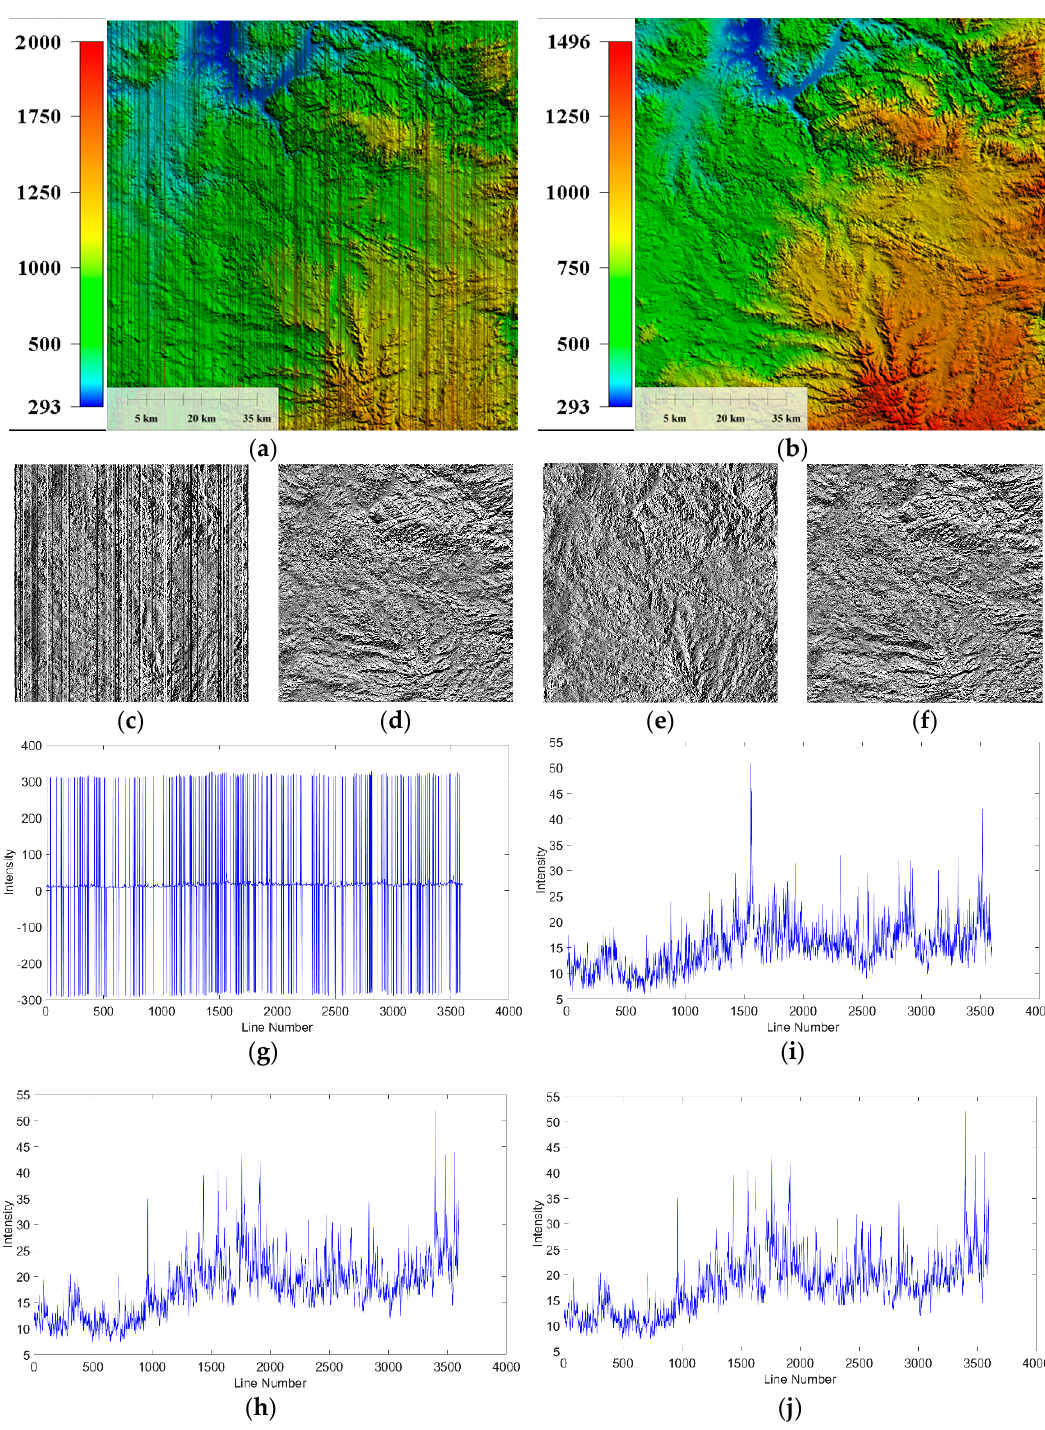
Figure 3. The interference of stripe errors on different gradient directions. The minimum elevation in this area is 293 m, the maximum elevation is 2000 m, and the maximum elevation difference is 1700 m. Analyzing the gradient decomposition in this rugged landscape, stripes of the regular distribution mainly affected the data for an elevational gradient in the direction orthogonal to it. In this experiment, stripe errors severely interfere with the horizontal gradient of the data. ( a ) Data with stripe errors, ( b ) clean data, ( c ) horizontal gradient of a, ( d ) vertical gradient of a, ( e ) horizontal gradient of b, ( f ) vertical gradient of b, ( g ) gradient intensity of c, ( h ) gradient intensity of d, ( i ) gradient intensity of e and ( j ) gradient intensity of f.